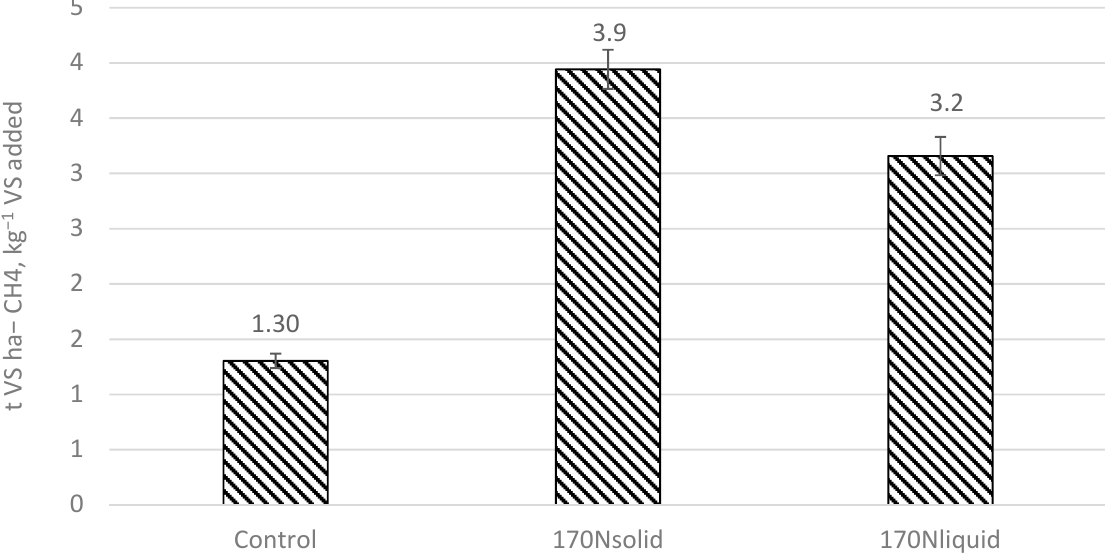
Figure 2. Semi-natural grassland biomass yield for solid (170 Nsolid) and liquid (170 Nliquid) digestate at a 170 kg N ha − 1 fertilization rate for three-year average experimental results. The yield is expressed in tons of volatile solids per hectare. Note: Data represented as mean ± standard deviation.